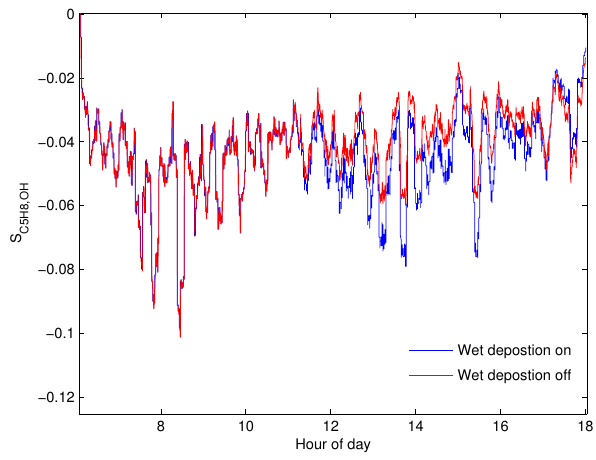
Fig. 8. S C modelled using a normally-distributed, randomly- 5 H 8 , OH generated isoprene time-series. The red line shows a run in which wet deposition was turned